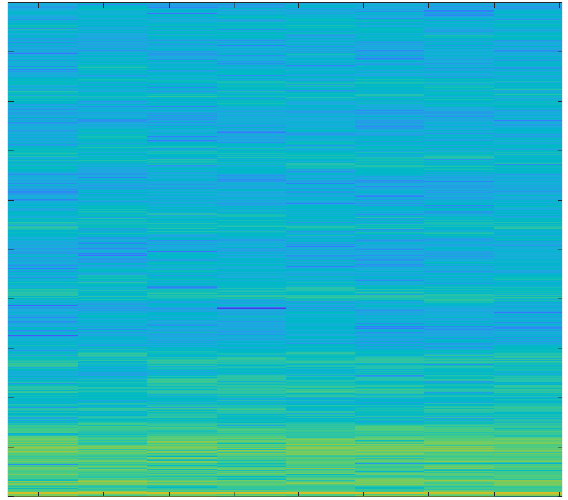
Figure 13. Hardwood, Worn-out Tool, 2 mm depth-of-cut.